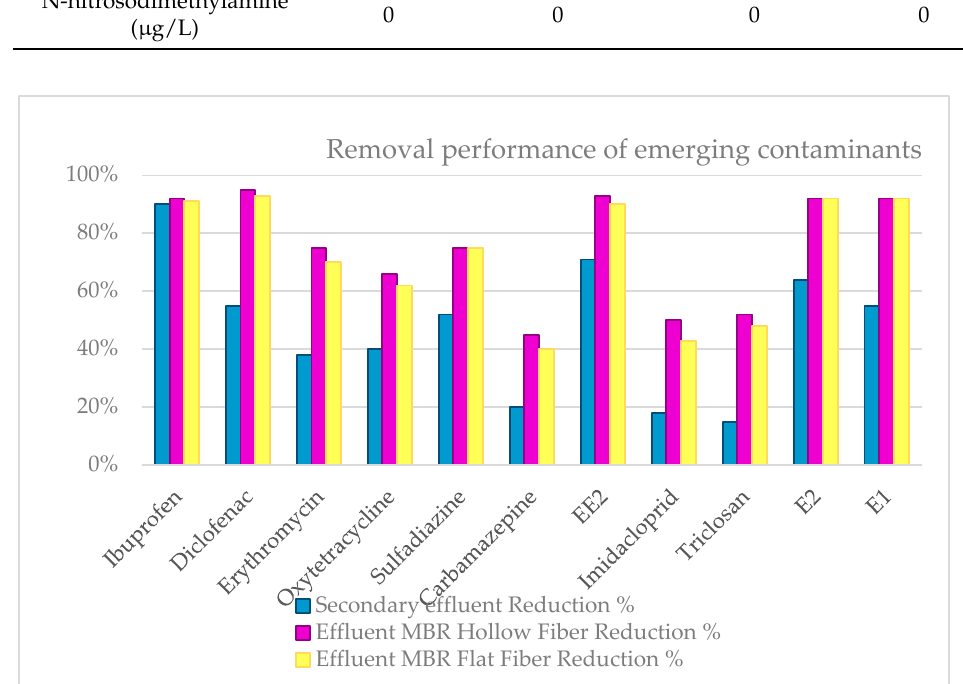
Figure 8. Comparison of removal efficiencies of emerging pollutants in secondary treatment WWTP, WWTP A, and WWTP B.